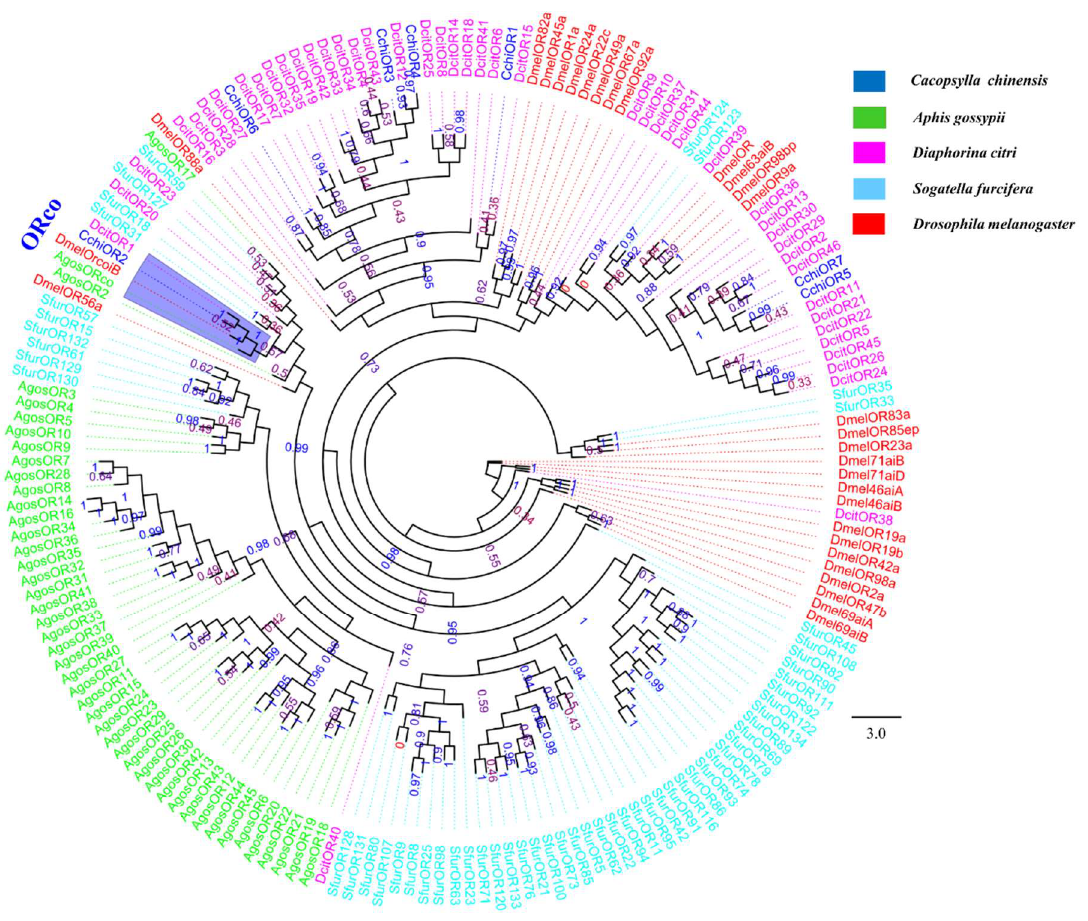
Figure 7. Phylogenetic tree of insect odorant receptors (ORs). The C. chinensis translated genes are shown in blue. Other insects are as follows: Aphis gossypii , Diaphorina citri, Sogatella furcifera, Drosophila melanogaster . Orco clade is marked in blue. This tree was constructed using PhyML based on the alignment results of ClustalX2.0.